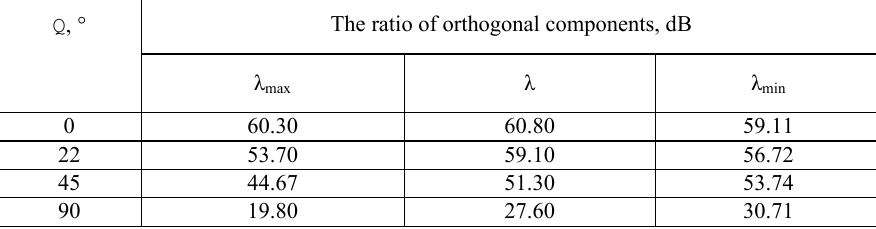
Table 2. The ratio of the orthogonal components of the electric field vector Е In the plane of the vector Е